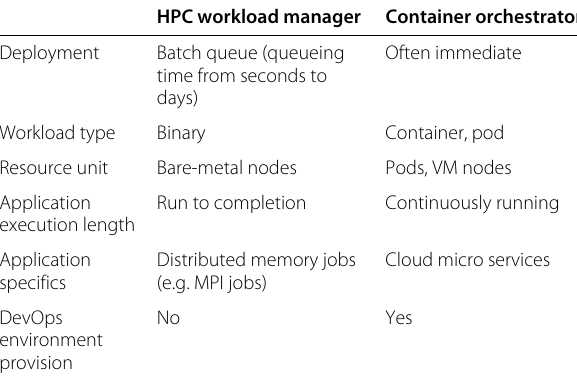
Table 1 Comparison of HPC workload managers and